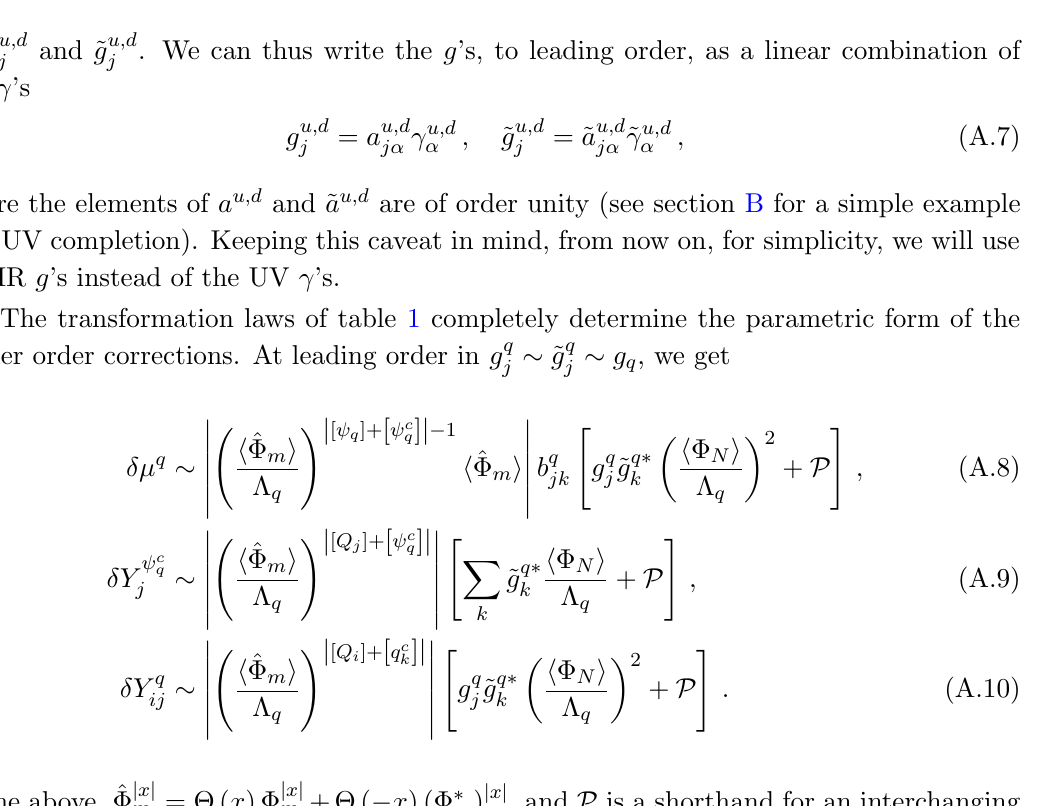
, which were presented in eq. (3.20). m